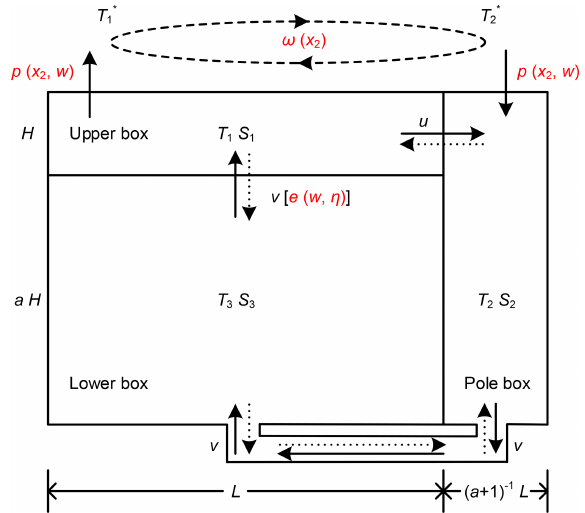
Figure 2. Schematic illustration of a three-box model for the ther- mohaline circulation. The volume of the upper box is the same as the volume of the pole box, and their volumes are both a multipli- cation of a − 1 and the volume of the lower box. L and H are the width and depth of the upper box, and T i and S i represent the tem- perature and salinity in box i . The upper boundary conditions are a temperature relaxation toward the specified reference temperature = T ∗ = 0 and a freshwater flux p . ω represents the wind- T ∗ , T ∗ 1 0 2 driven gyre between the upper box and pole box. u is the horizontal water flow and v is the overturning rate. The red terms represent the main influencing factors of v and multiple equilibria and which variables in the five-variable model they will be combined with. The solid (dotted) arrows in the three boxes indicate the thermal (haline) mode, with circulation flowing clockwise